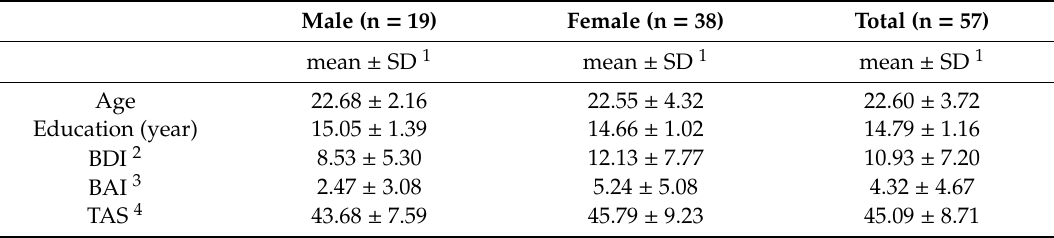
Table 2. Characteristics of participants.